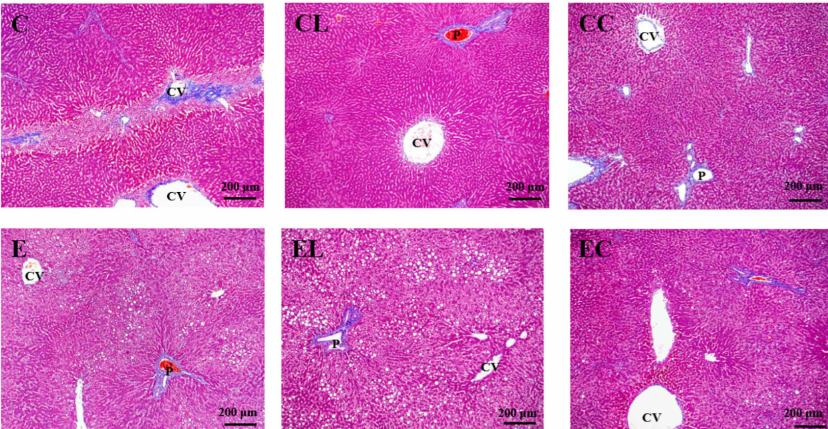
Figure 2. Effects of different dietary fat sources on Masson’s trichrome staining of liver tissue sections in rats. CV, central vein; P, portal area. C, control group; CL, control diet with lard group; CC, control diet with cocoa butter group; E, ethanol group; EL, ethanol diet with lard group; EC, ethanol diet with cocoa butter group.